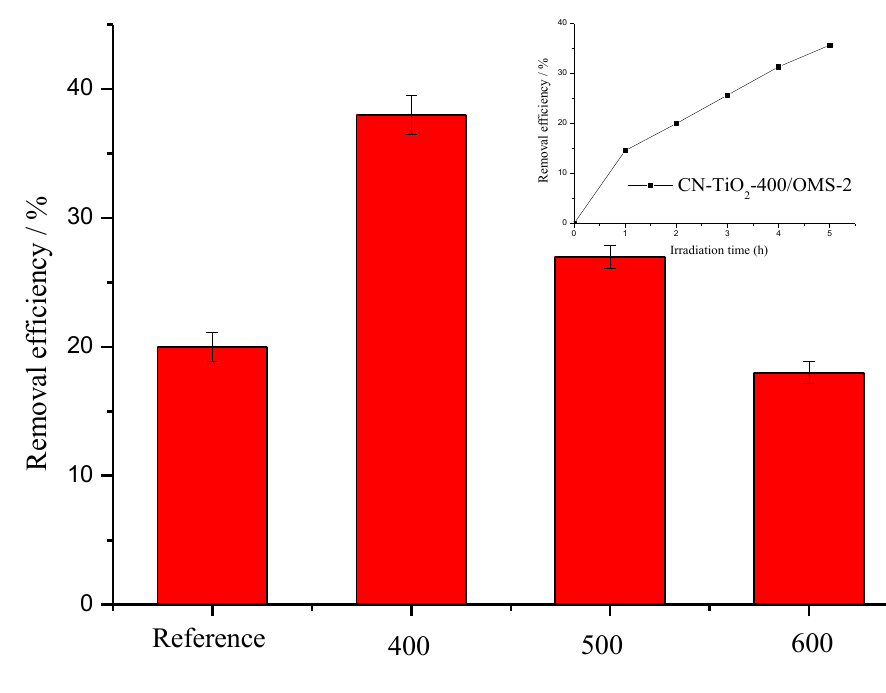
Figure 5. The dependence of the removal efficiency ( R (%)) of photocatalytic oxidation of methyl orange under daylight irradiation on calcination temperature (Insertion is methyl degradation by CN-TiO 2